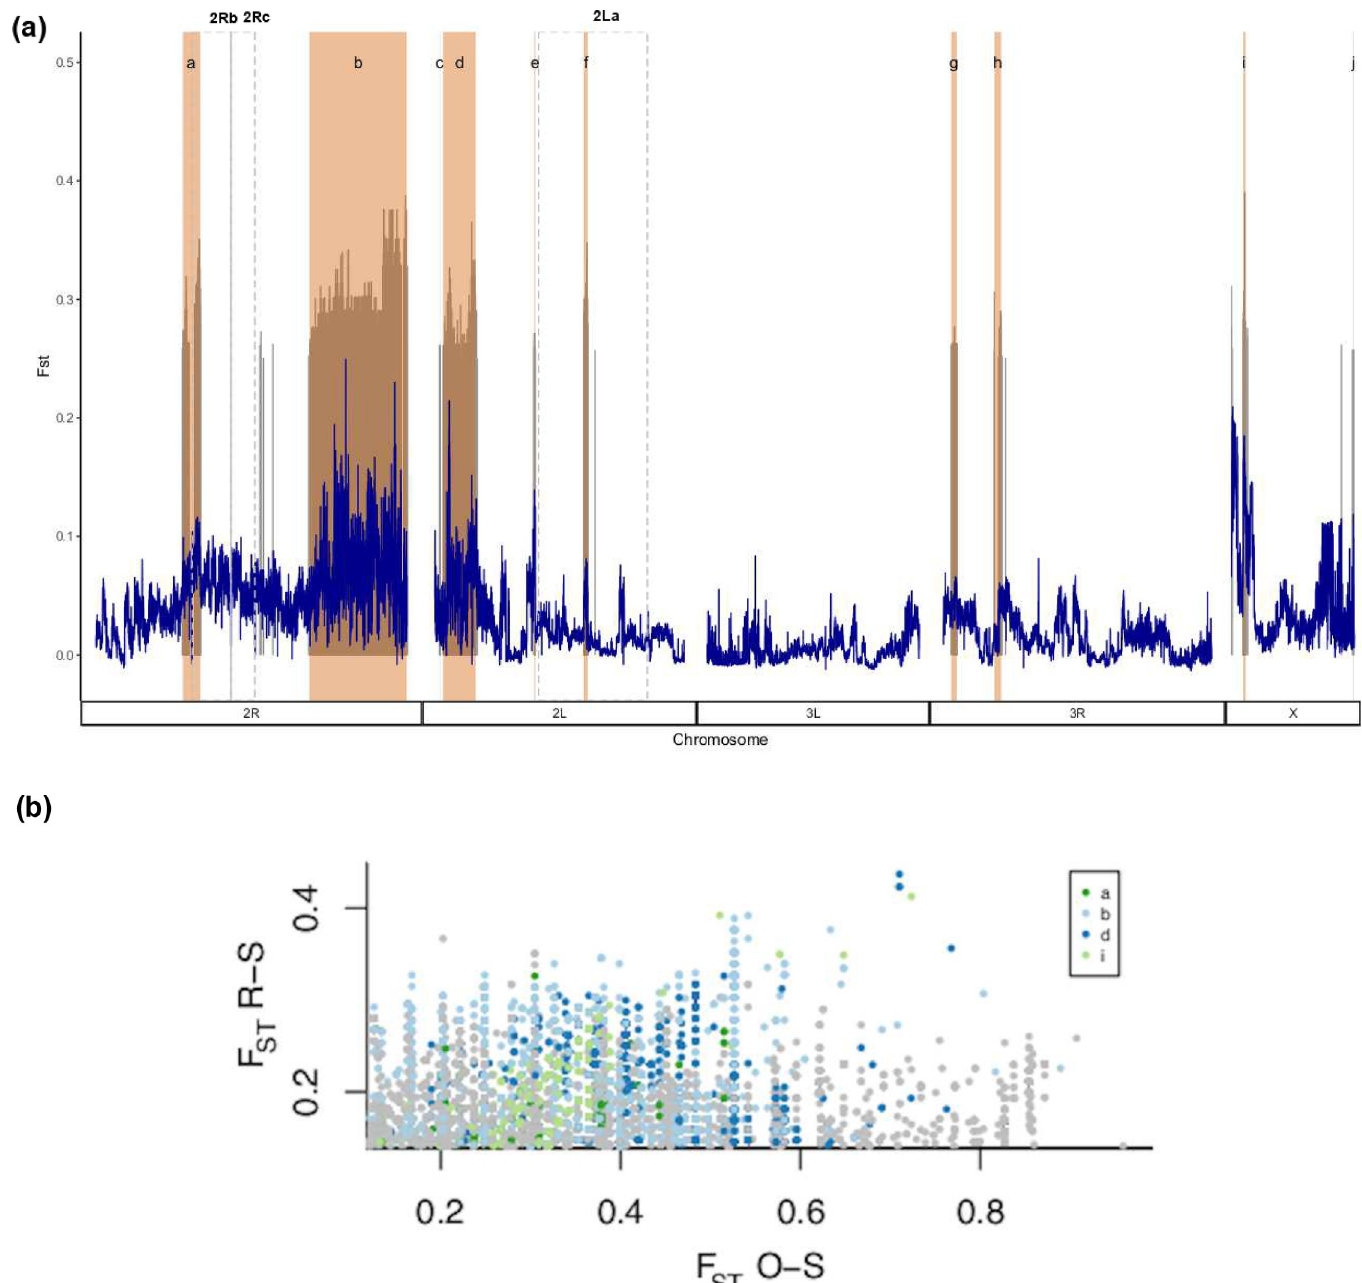
Fig 5. F ST between Reselected and Susceptible populations. (a) F ST (y axis) and chromosomal position (x axis) of reselected compared to susceptible populations. Dark blue shows the average F ST over 10kb windows and grey are individual SNPs with F ST > 0.25. Shaded in pink are regions identified as blocks of divergent SNPs, the inversions are highlighted by dashed grey boxes. (b) SNPs showing high F ST and allele frequency difference in the same direction relative to Banfora-S, for Banfora-O and Banfora-R. Several SNP blocks as in part (a) (blocks a, b, d, and i) are